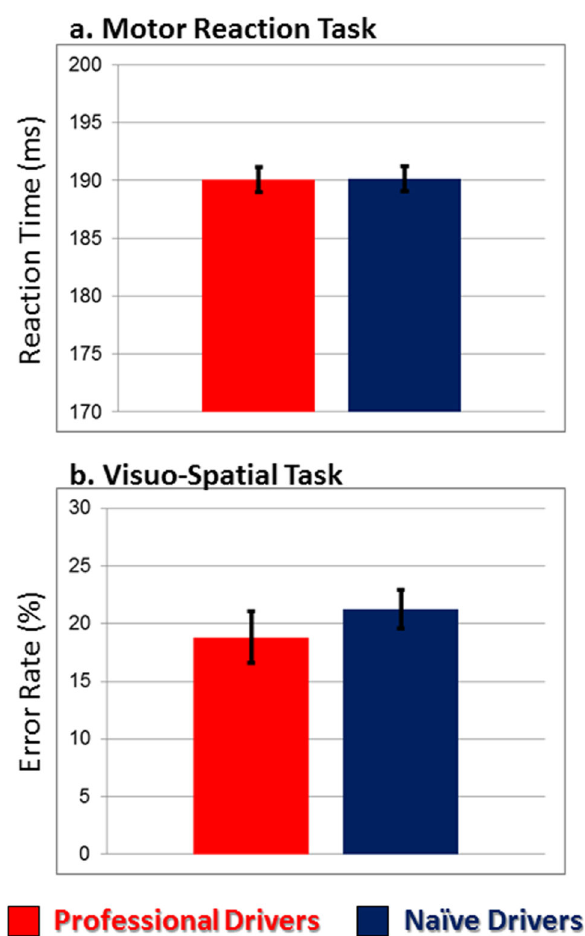
Figure 2. Behavioural results. Behavioural performance of professional (red) and naïve (blue) drivers during the motor reaction task (a) and the visuo-spatial task (b). Average reaction time and mean error rate (± SE) are shown in the graphs. No significant differences between the two groups have been observed.